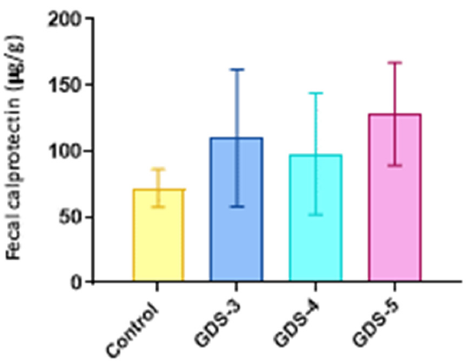
Figure 11. Calprotectin in the Alzheimer’s disease (AD) patients and the control subjects. The fecal samples from the control subjects and the AD patients classified in the stages GDS-3, GDS-4 and GDS-5. The fecal calprotectin levels were expressed as µg calprotectin/g of the feces. The data are the means ± the SEM; (n = 10, control subjects; n = 12, AD patients; 4 per stage).